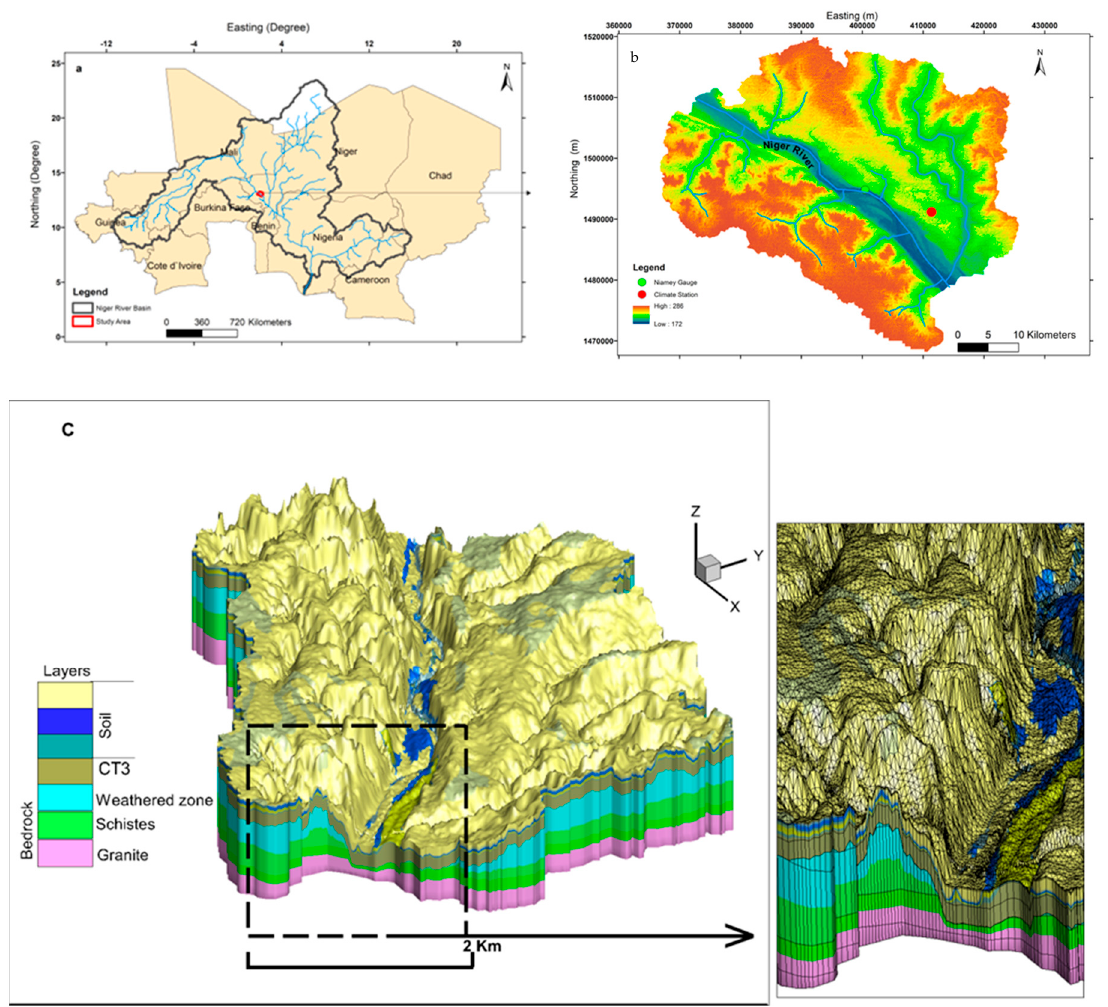
Figure 1. ( a ) Study area location within the Niger River basin. ( b ) Local context of the study area with topography and stream network. ( c ) Three-dimensional (3D) surface–subsurface model of the study area.